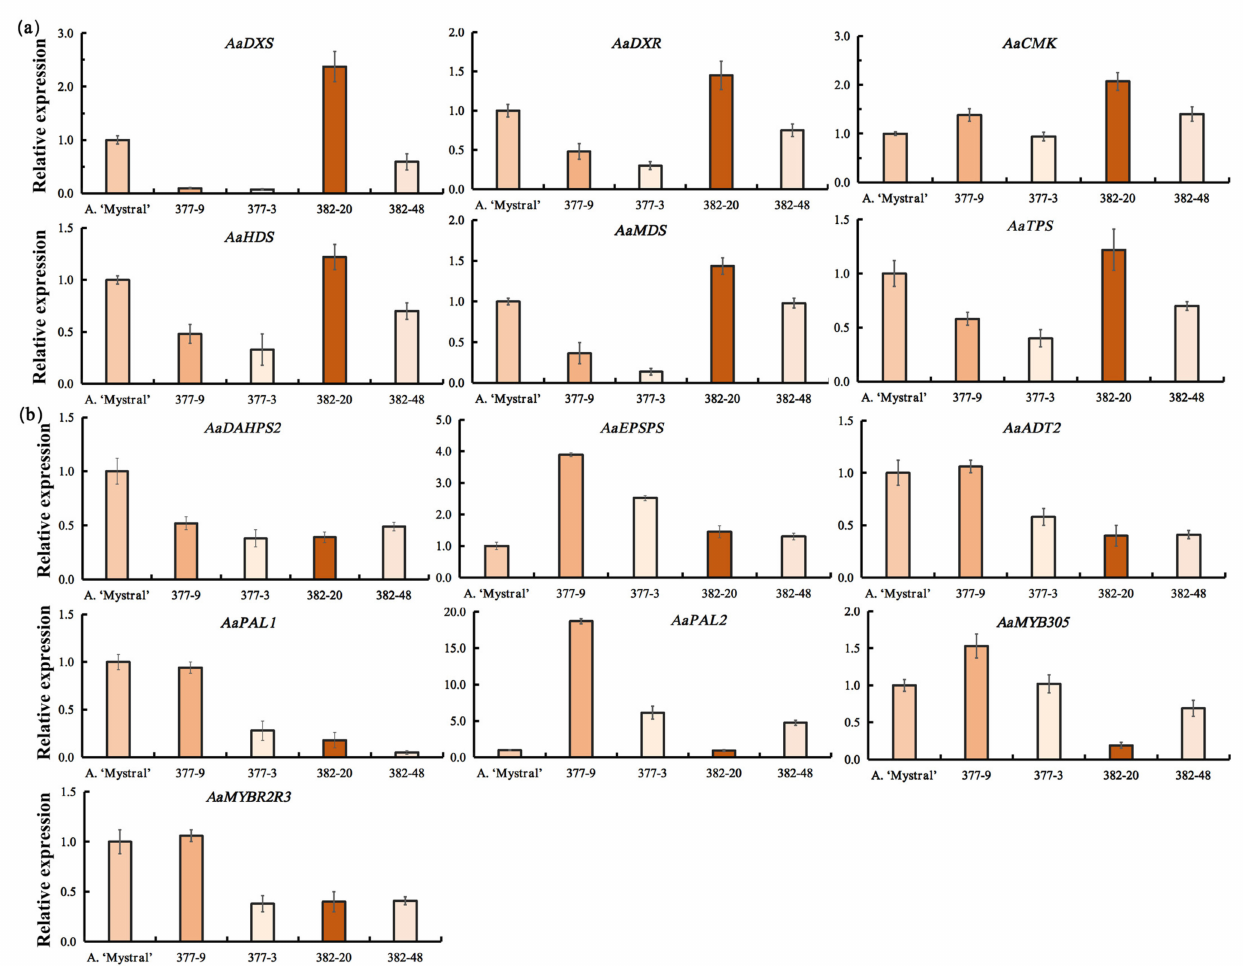
Figure 4. The relative expression levels of VOC biosynthesis-related genes in the top part of the inflorescences of progenies and A. ‘Mystral’ . ( a ) The relative expression levels of monoterpene biosynthesis-related genes; ( b ) The relative expression levels of key genes in phenylpropane biosynthesis or shikimate pathways. The relative bar color intensities represent the total amount of